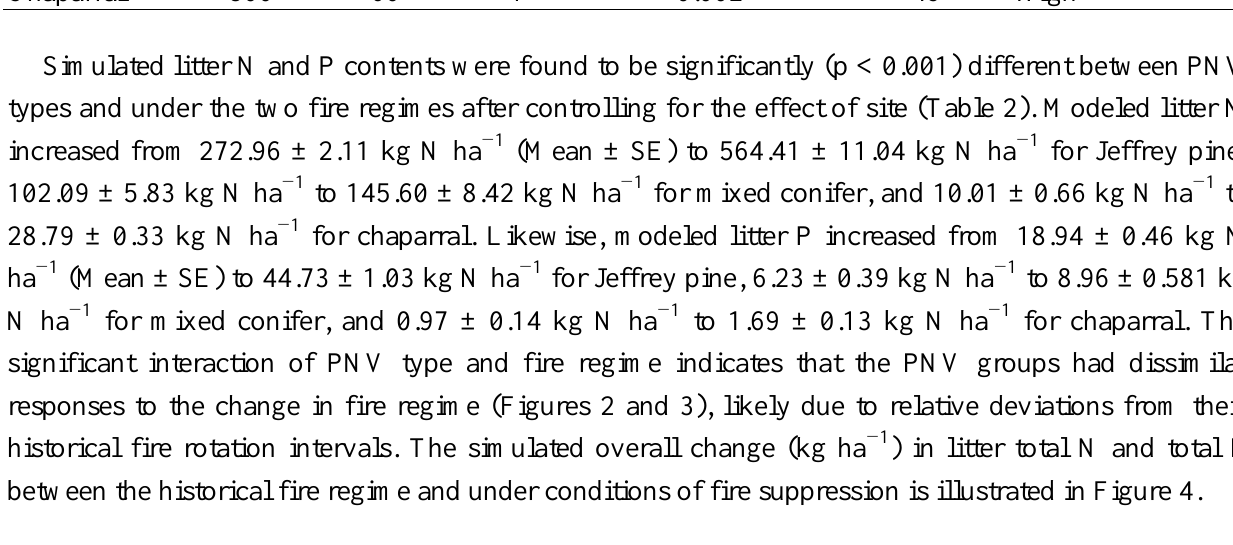
Table 2. Simulated litter N and P (means ± SE) for each potential natural vegetation type under conditions of historical fire regime and fire suppression.